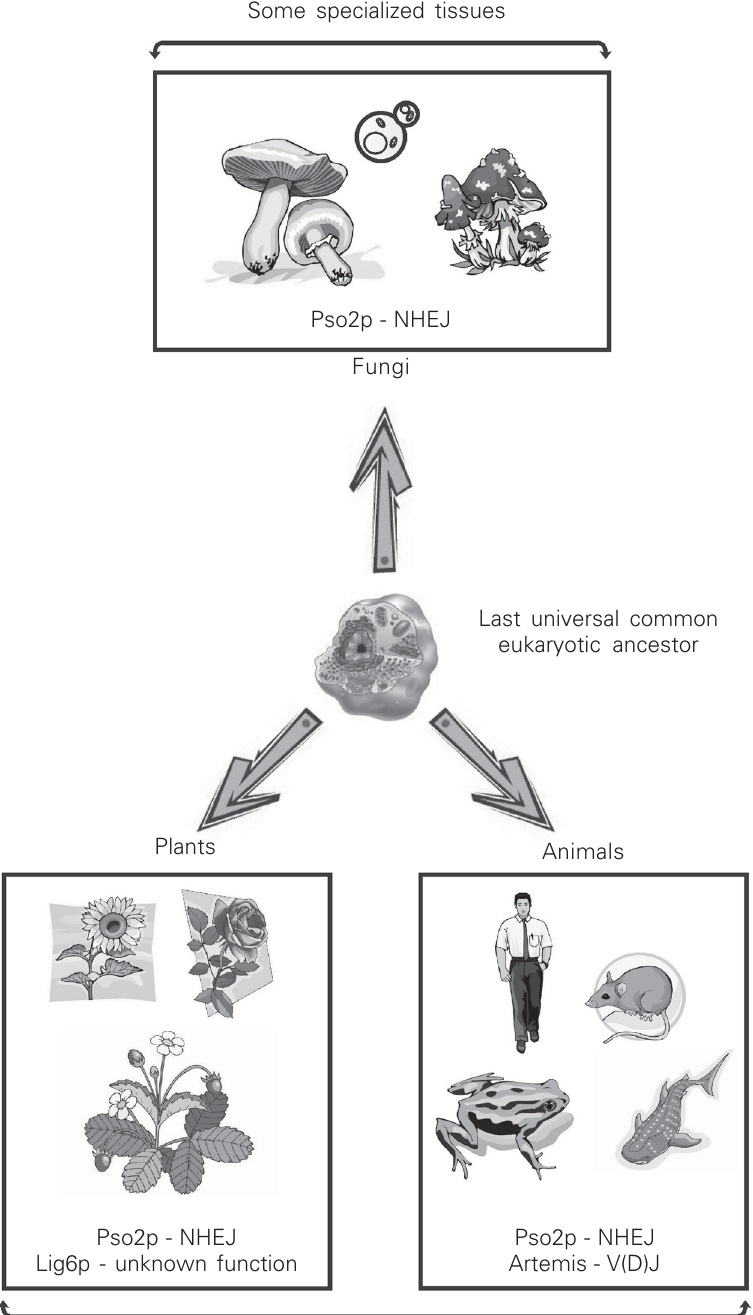
Figure 4. Evolutionary diversification of Pso2p in fungi, animals, and plants from a last universal common eukaryotic ancestor. Artemis and Lig6p are represented within animals and plants, respectively. Animals and plants contain paralogous PSO2 genes, but they are represented by a single sequence for clarity. Fungi contain only one Pso2p sequence. This diversification might be linked to the tissue diversity found in higher eukaryotes (animals and plants). NHEJ = non-homologous end